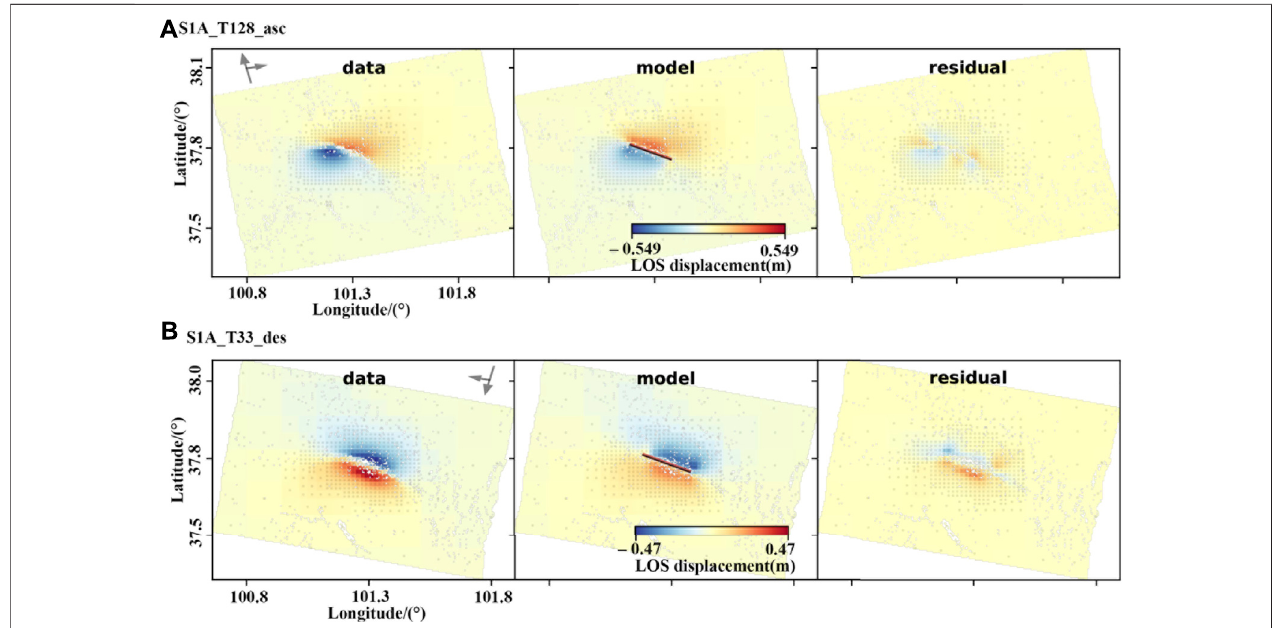
FIGURE 6 | Uniform slip inversion result of the 2022 Menyuan earthquake, including observed, modeled, and residual data. (A) Sentinel-1A in ascending track (T128). (B) Sentinel-1A in descending track (T33).